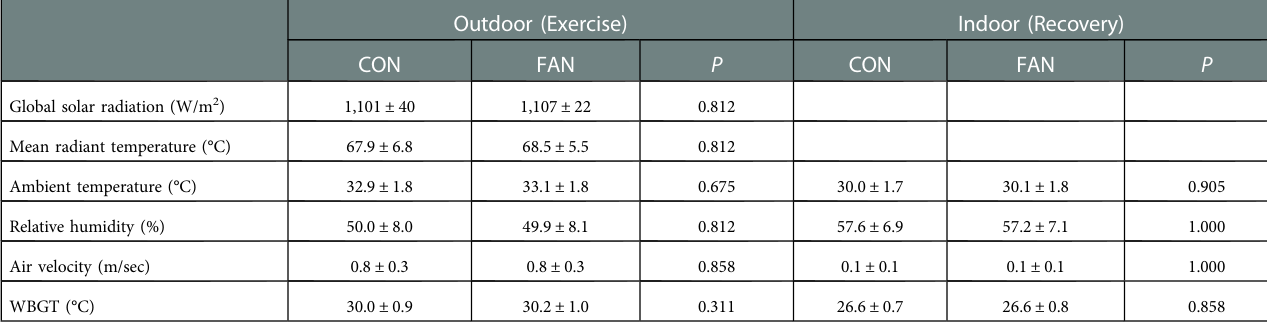
TABLE 1 Environmental conditions at the end of outdoor exercise and during indoor recovery periods. Outdoor (Exercise) Indoor